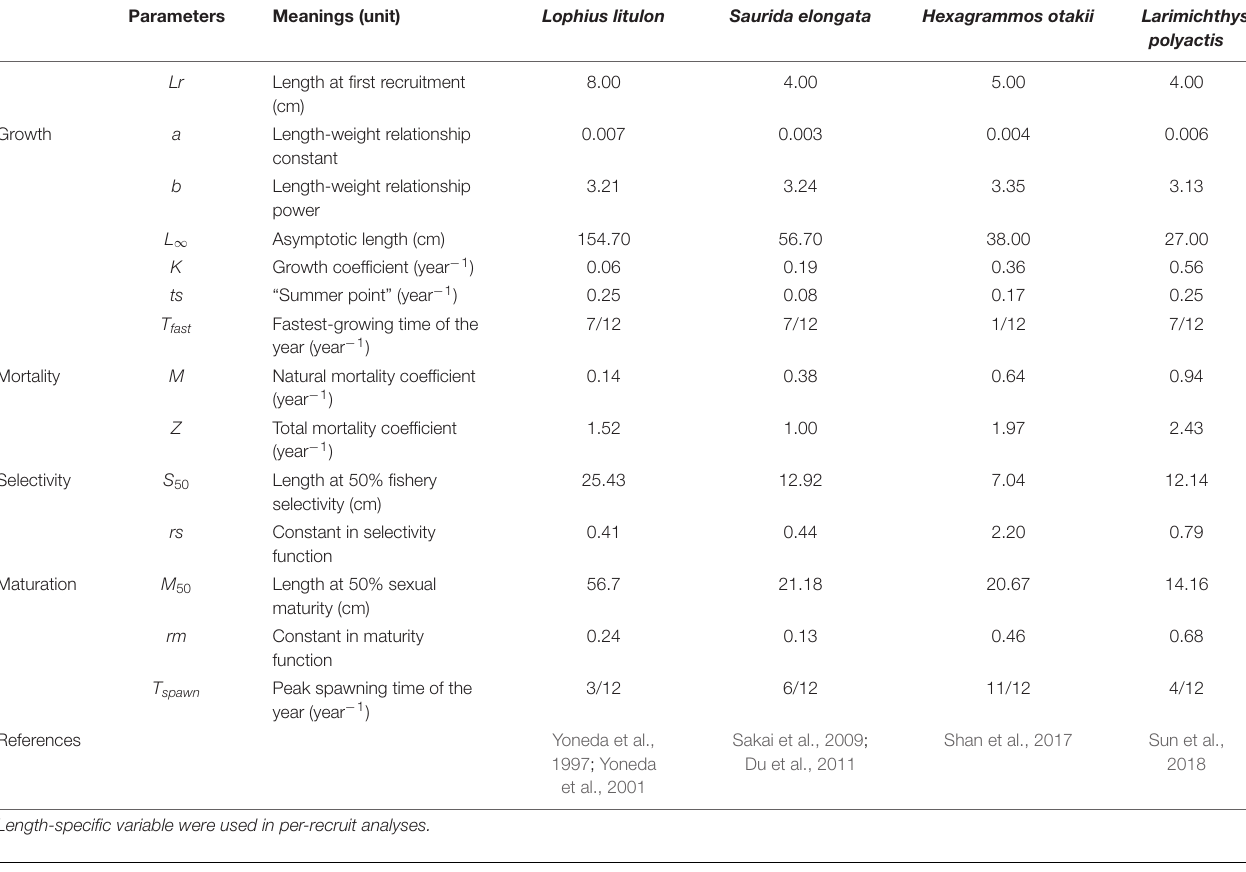
TABLE 1 | Input parameters used in per-recruit analyses and simulation.